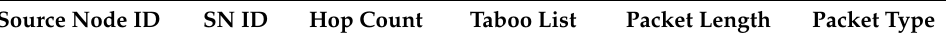
Table 1. The format of the routing